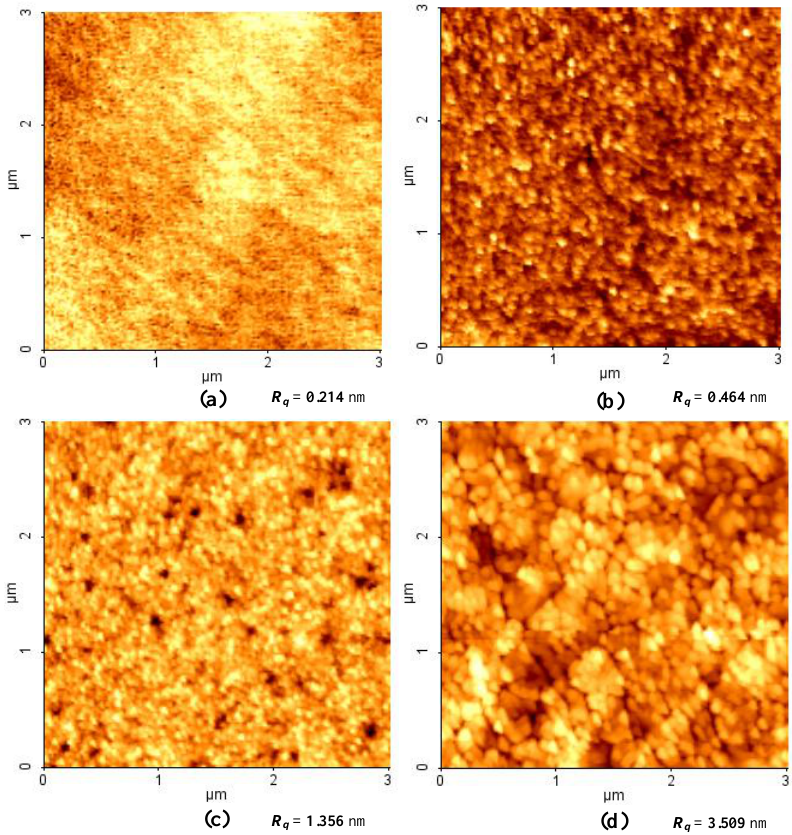
Figure 6. 2D AFM images of TiO ( d ) 900